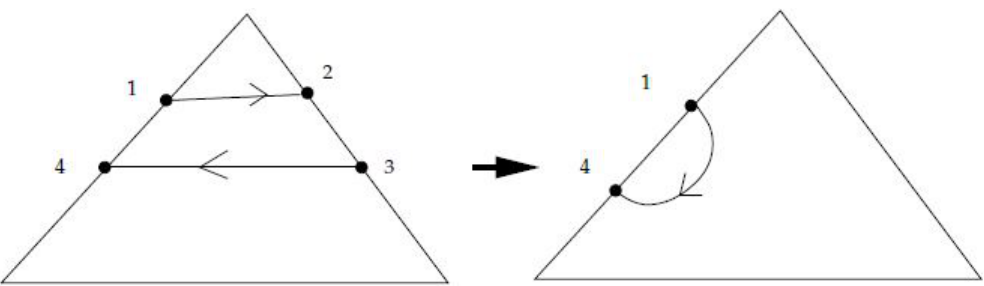
Figure 15. Resolving parallel components.